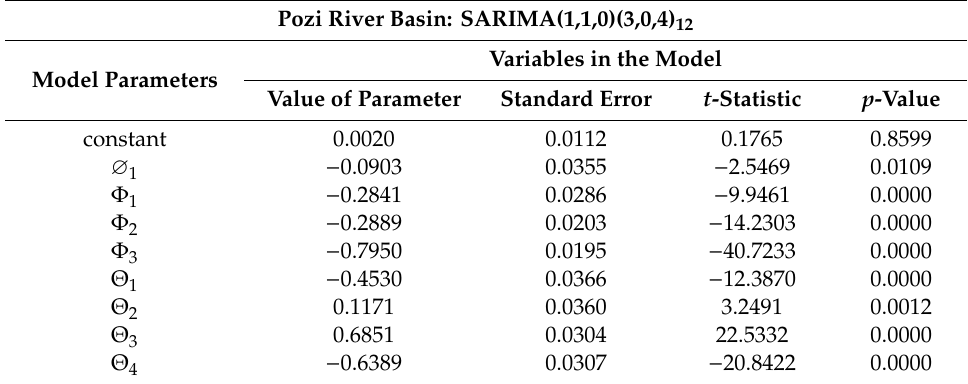
Table 3. Statistical analysis of the model parameters for the PR1 station in the Pozi River basin.